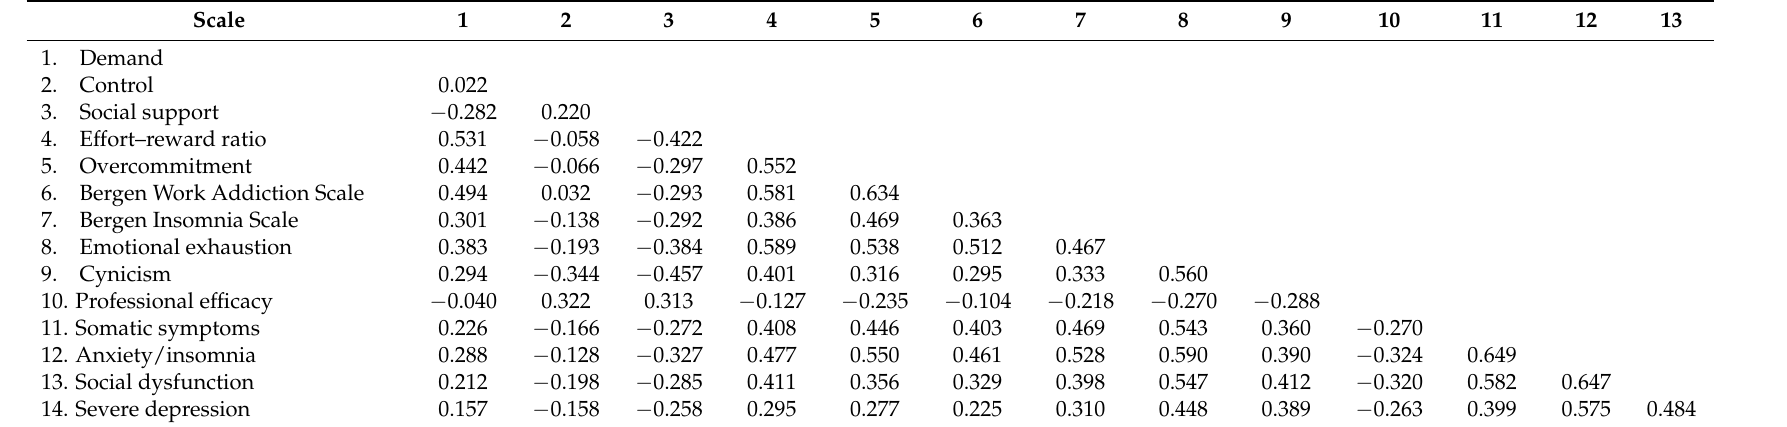
Table 2. Zero-order correlations (Pearson product–moment coefficients; r) between study variables.